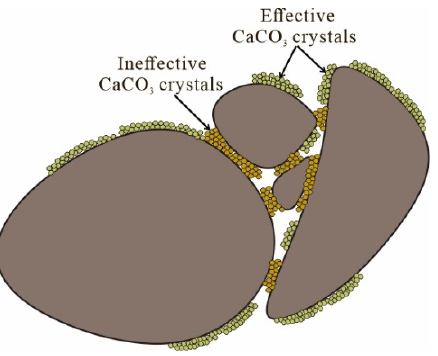
Figure 10. Schematic diagram of ineffective and effective CaCO 3 crystals in cemented samples.